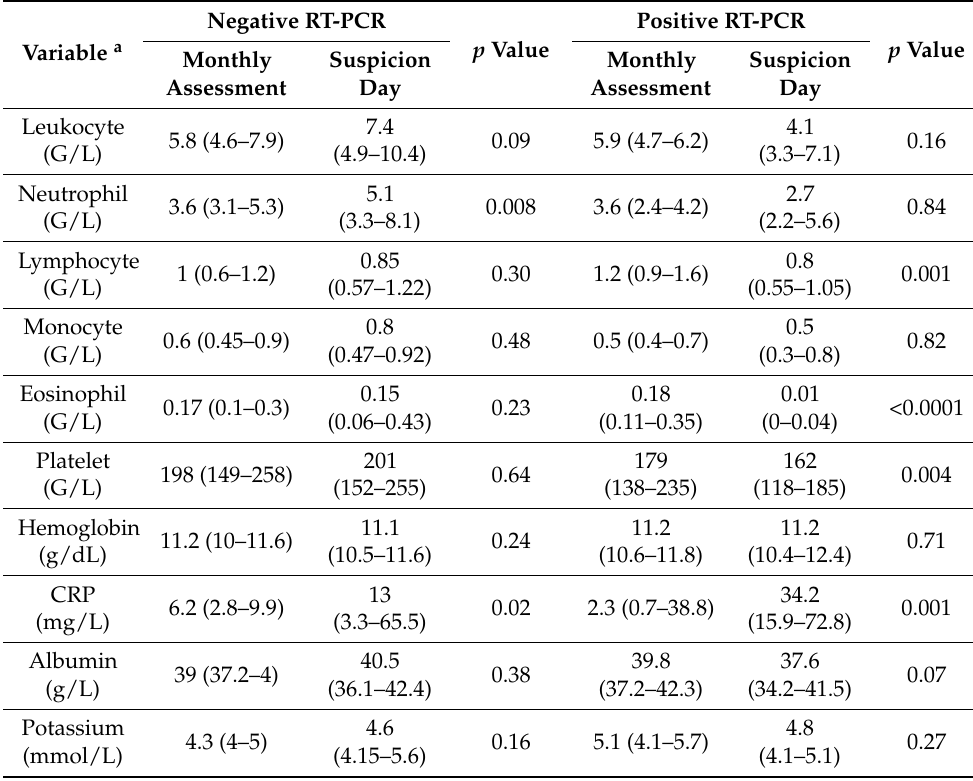
Table 3. Biological comparison between March monitoring and the suspicion